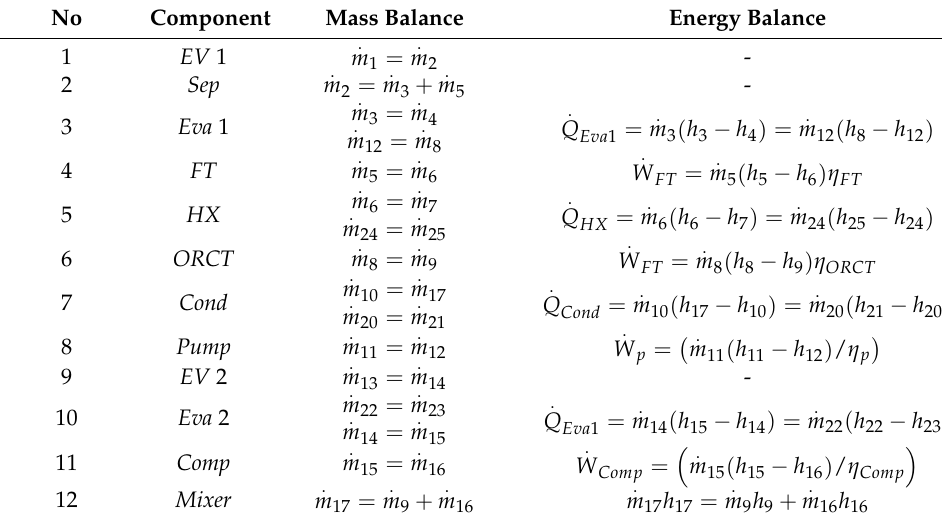
Table 2. Equations of mass and energy balances